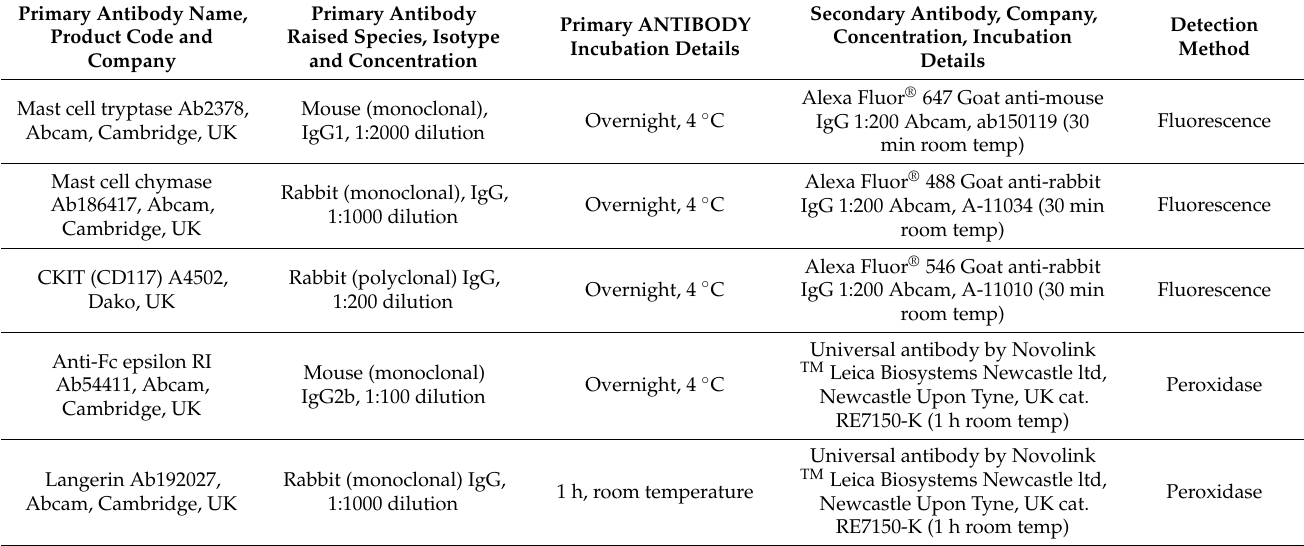
Table 3. Immunohistochemical antibodies. Primary antibodies, secondary antibodies, concentration of antibodies, incuba- tion times and detection methods used for immunohistochemistry in this